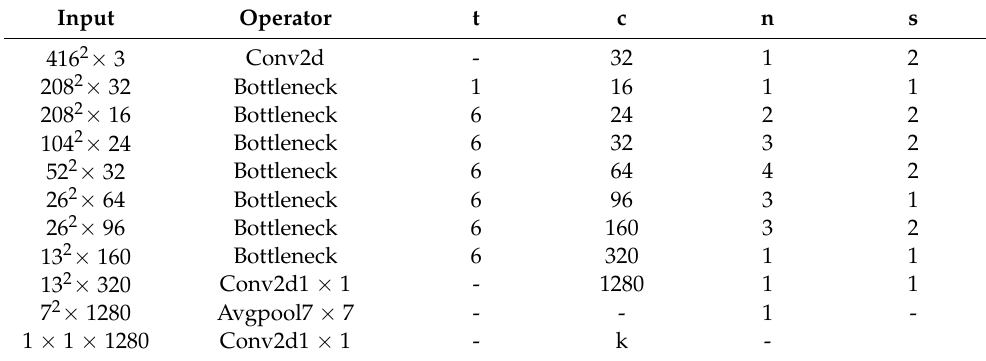
Table 1. Overall structure of